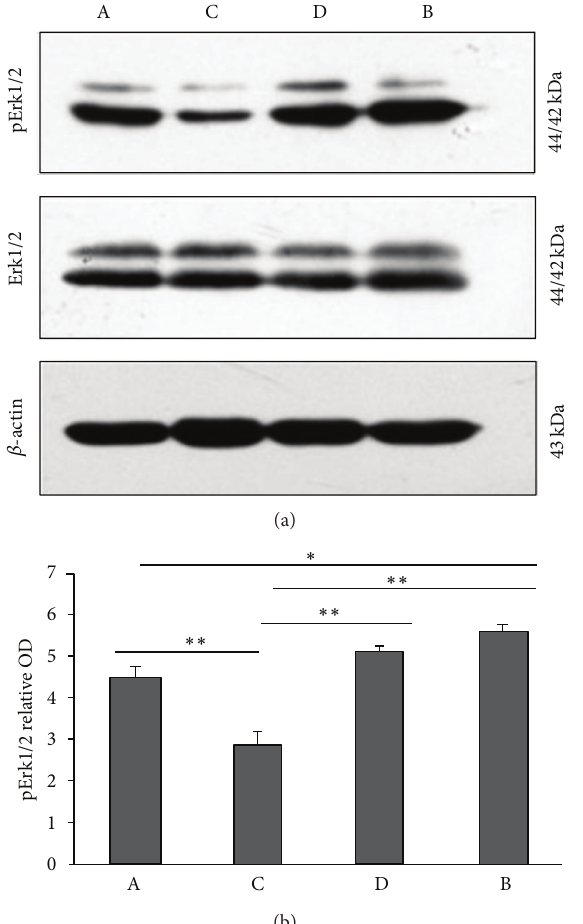
Figure 5: Western blot showed the expression of Erk1/2 and pErk1/2 in hippocampal tissue in rats. (a) The representative photos of western blot. (b) The statistical analysis of western blot. Data shown are mean ± SEM. ∗ 𝑃 < 0.05 , ∗∗ 𝑃 < 0.01